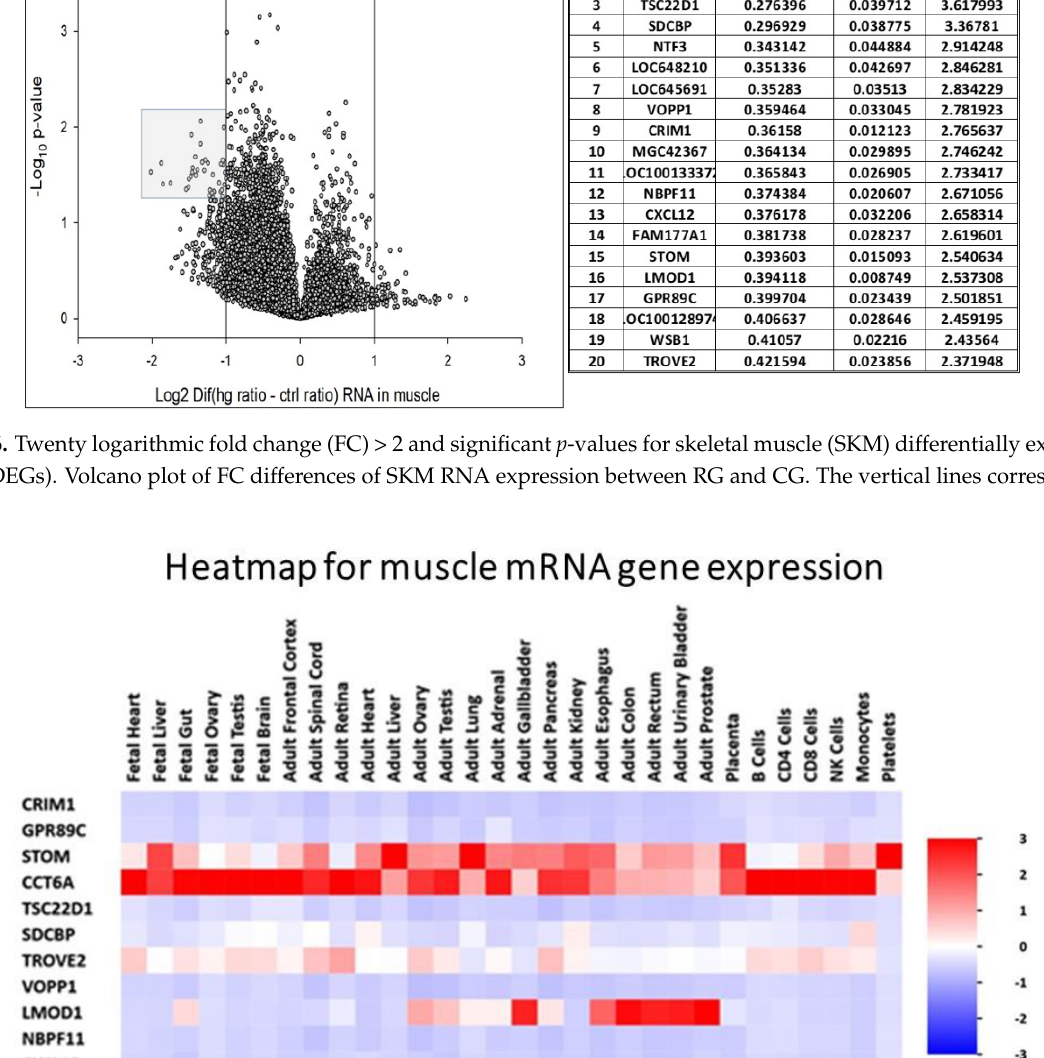
Figure 8. Graphical representation of enrichment analysis and interaction networks obtained through the FunRich database analysis tool for gene annotation pertaining to transcript expression associations in SKM tissue.